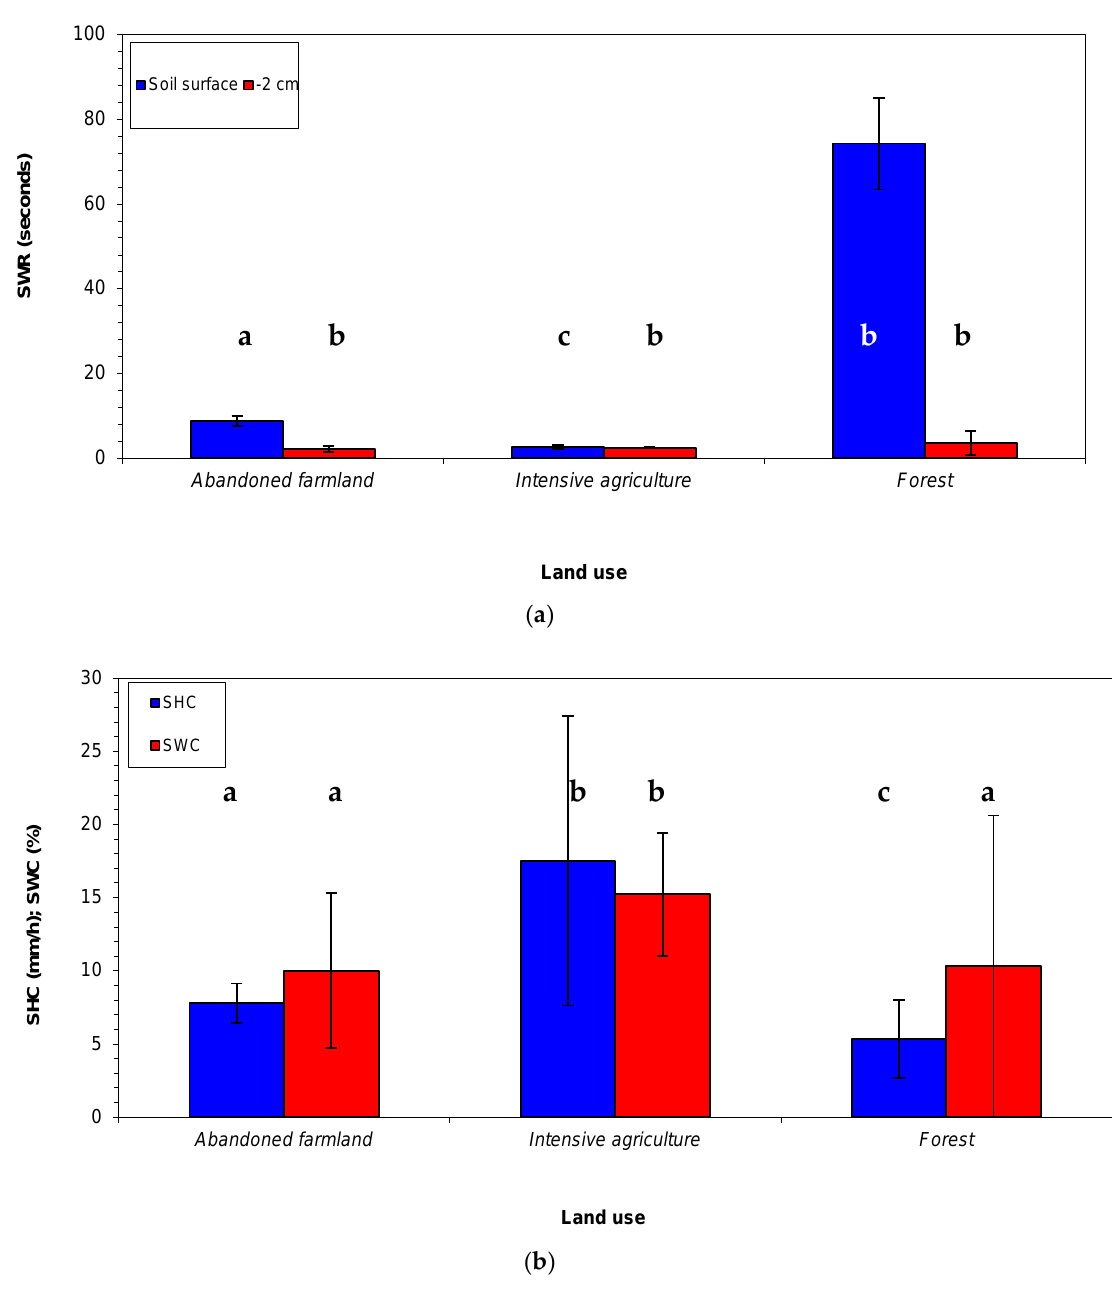
Figure 3. Soil water repellency (SWR, measured on the soil surface and at 2 cm below ground, ( a ), water content (SWC, b ) and hydraulic conductivity (SHC, b ) in the study area (Villamalea, Castilla La Mancha, SE Spain). Different lower-case letters indicate statistically significant differences comparing land uses for SWC and SHC following LSD test (P-value < 0.05).